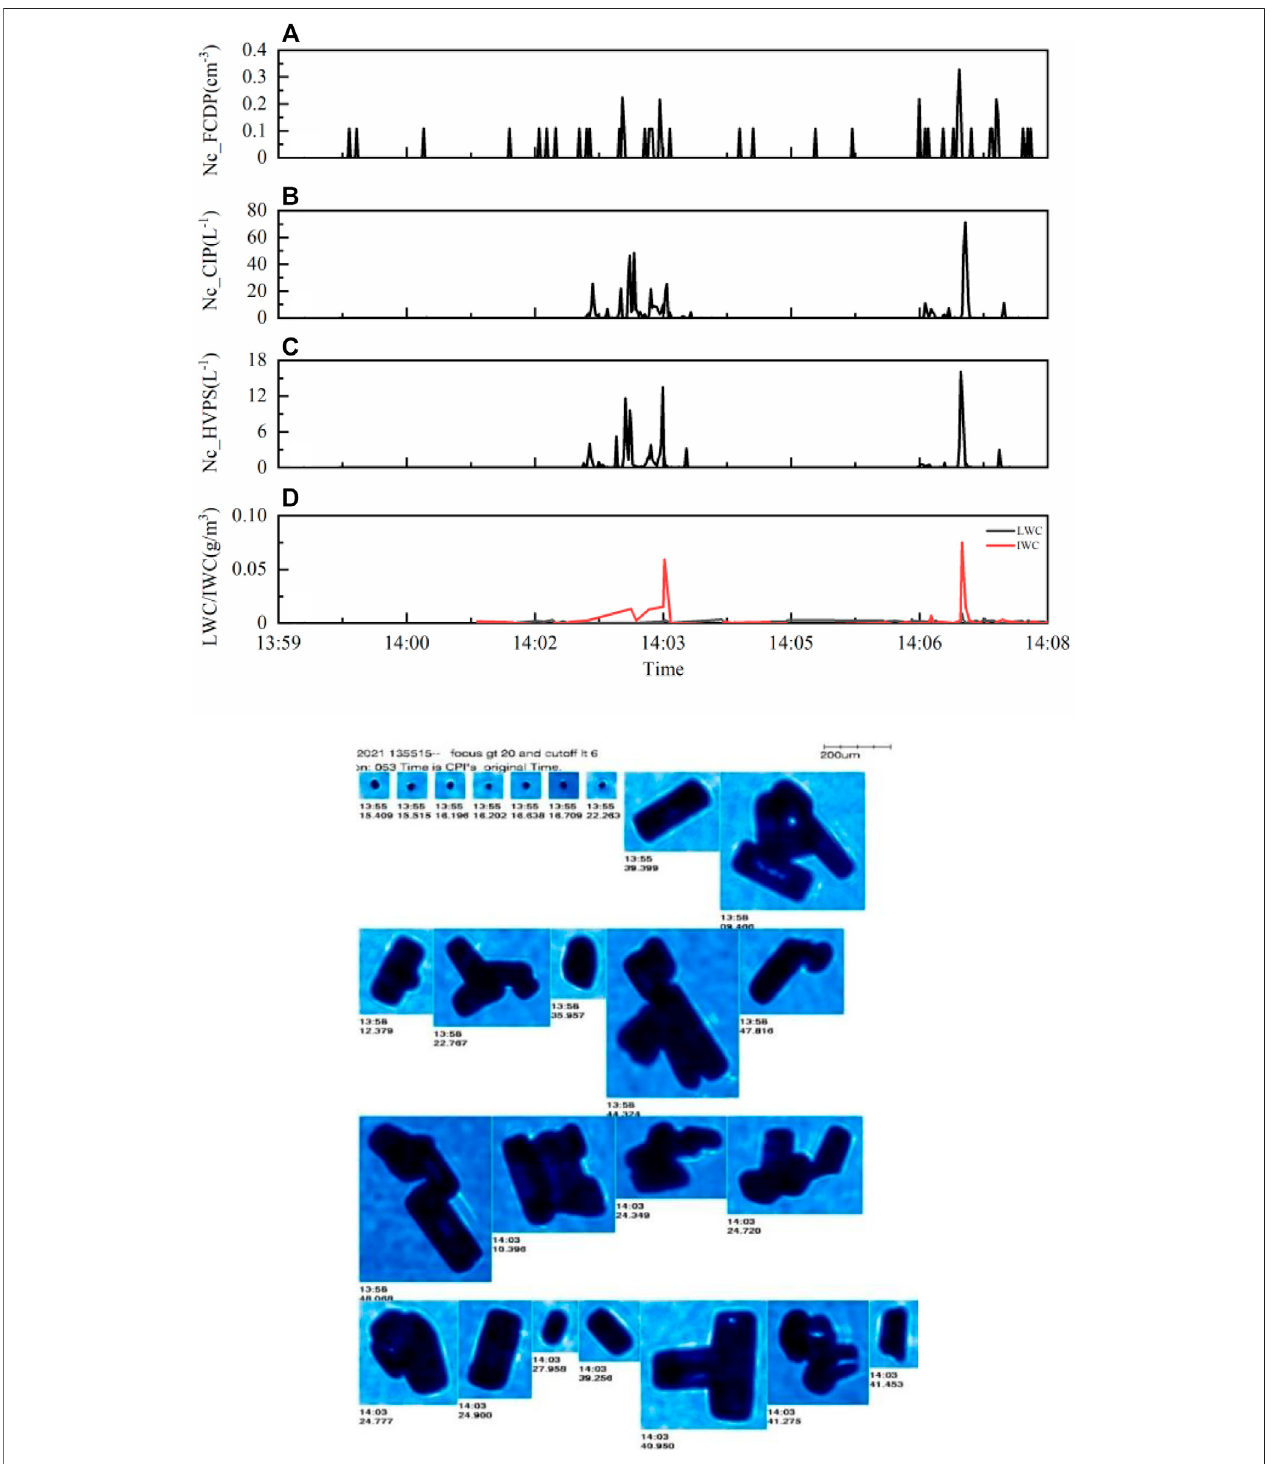
FIGURE 10 | The temporal change of cloud particle number concentration measured by fast cloud droplet probe (A) , cloud imager probe (B) , high-volume precipitation spectrometer (C) , and liquid water content and ice water content (D) measured by Nevzorov hotwire and particle images (below) at 4,700 m.